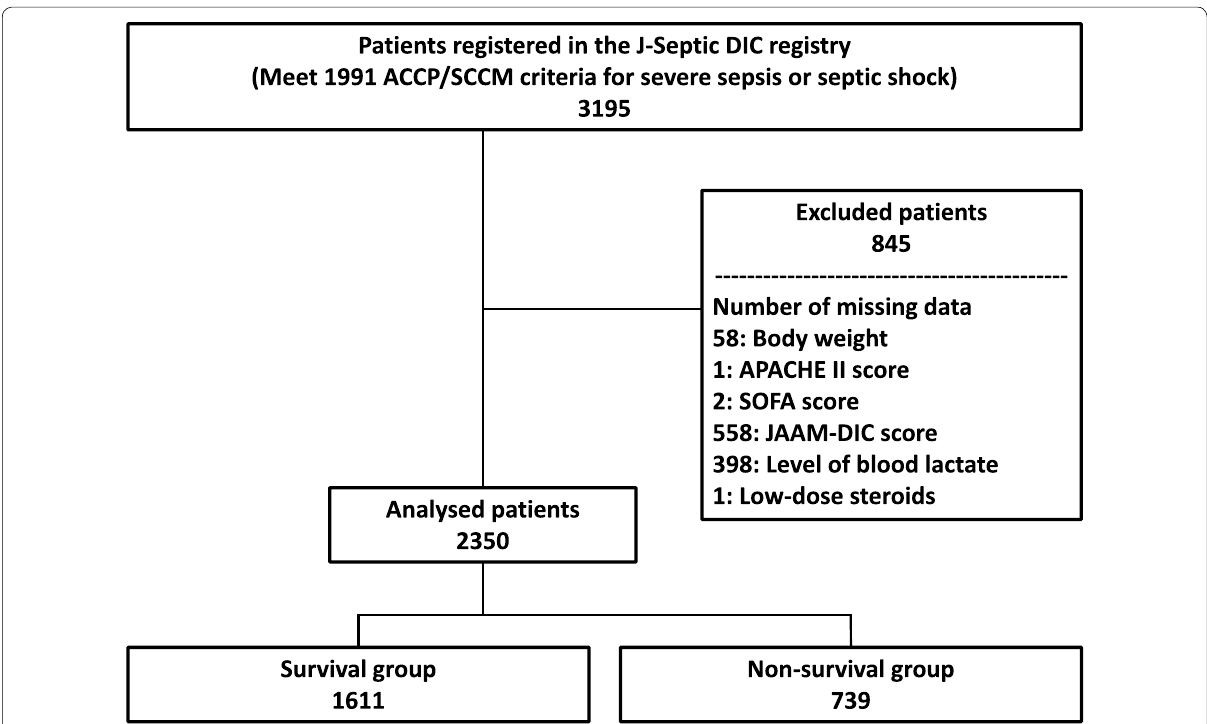
Fig. 1 Study flowchart. The numbers of patients are indicated in each box. ACCP American College of Chest Physicians, APACHE Acute Physiology and Chronic Health Evaluation, DIC disseminated intravascular coagulation, JAAM Japanese Association for Acute Medicine, J-Septic DIC Japan Septic Disseminated Intravascular Coagulation, SCCM Society of Critical Care Medicine, SOFA Sequential Organ Failure